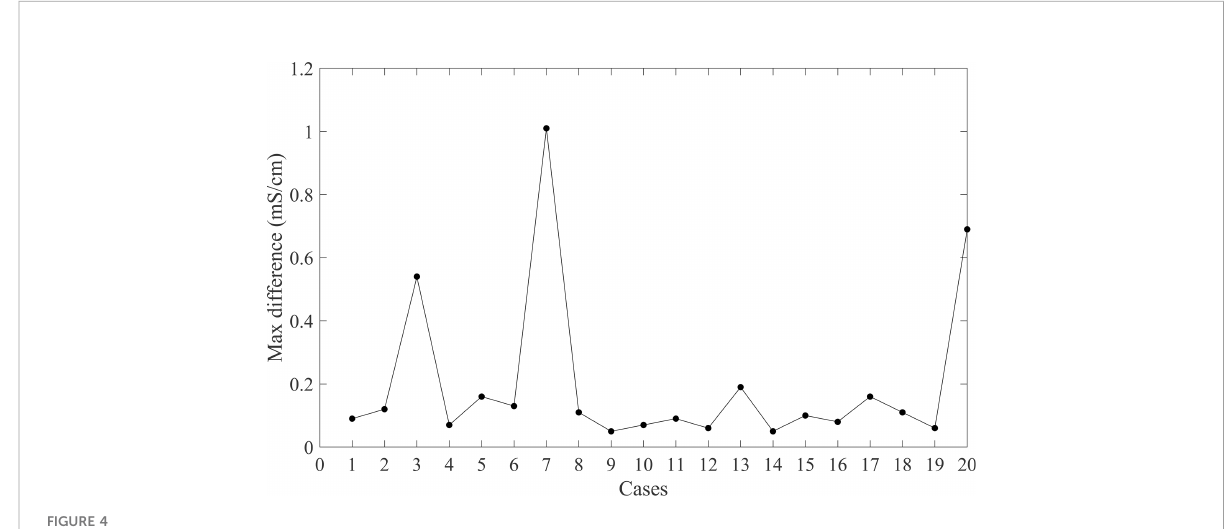
FIGURE 4 Maximum conductivity deviation of